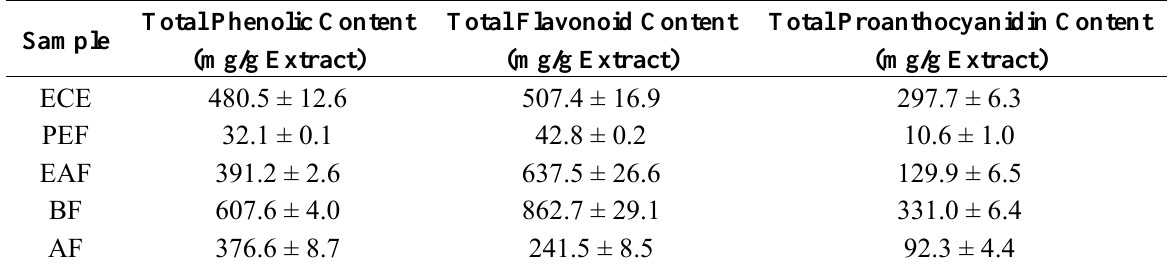
Table 1. Contents of total phenolics, flavonoids, and proanthocyanidins of ethanolic crude extract and fractions of Receptaculum Nelumbinis. ECE, ethanolic crude extract; PEF, petroleum ether fraction; EAF, ethyl acetate fraction; BF, n -butanol fraction; AF, aqueous